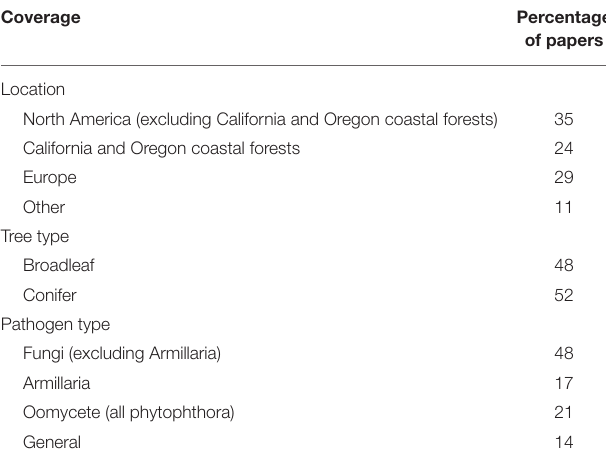
TABLE 1 | Overview of coverage of identified